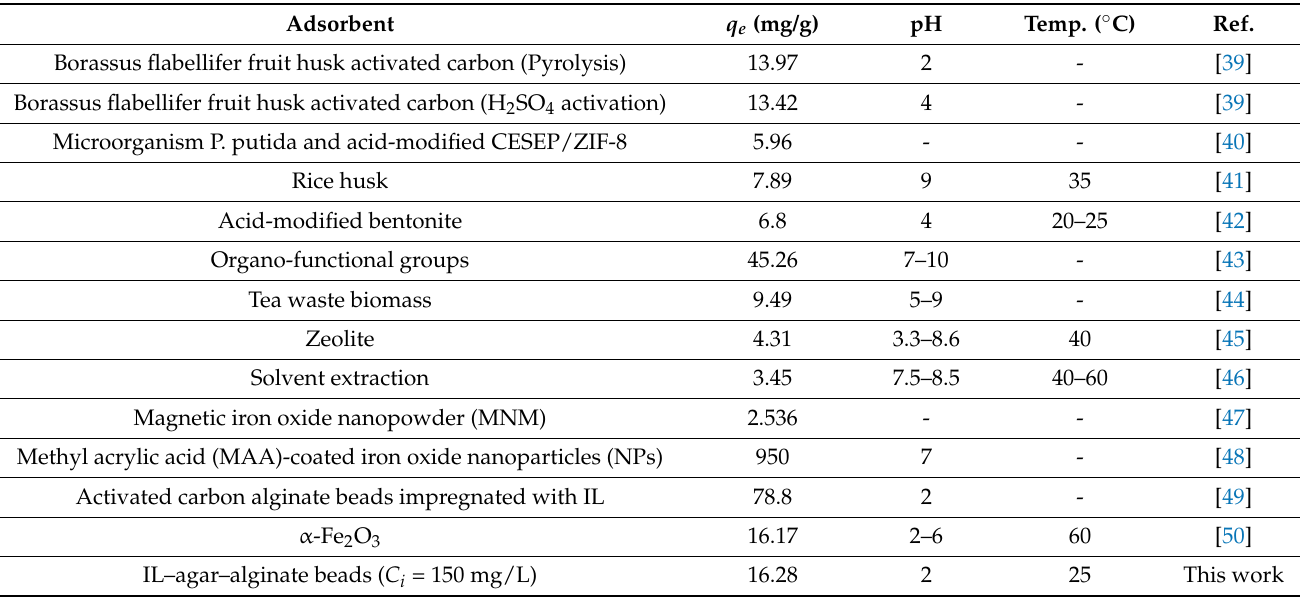
Table 6. Comparison of the adsorption capacity, pH and temperature of IL–agar–alginate beads for phenol removal with previously reported adsorbents.